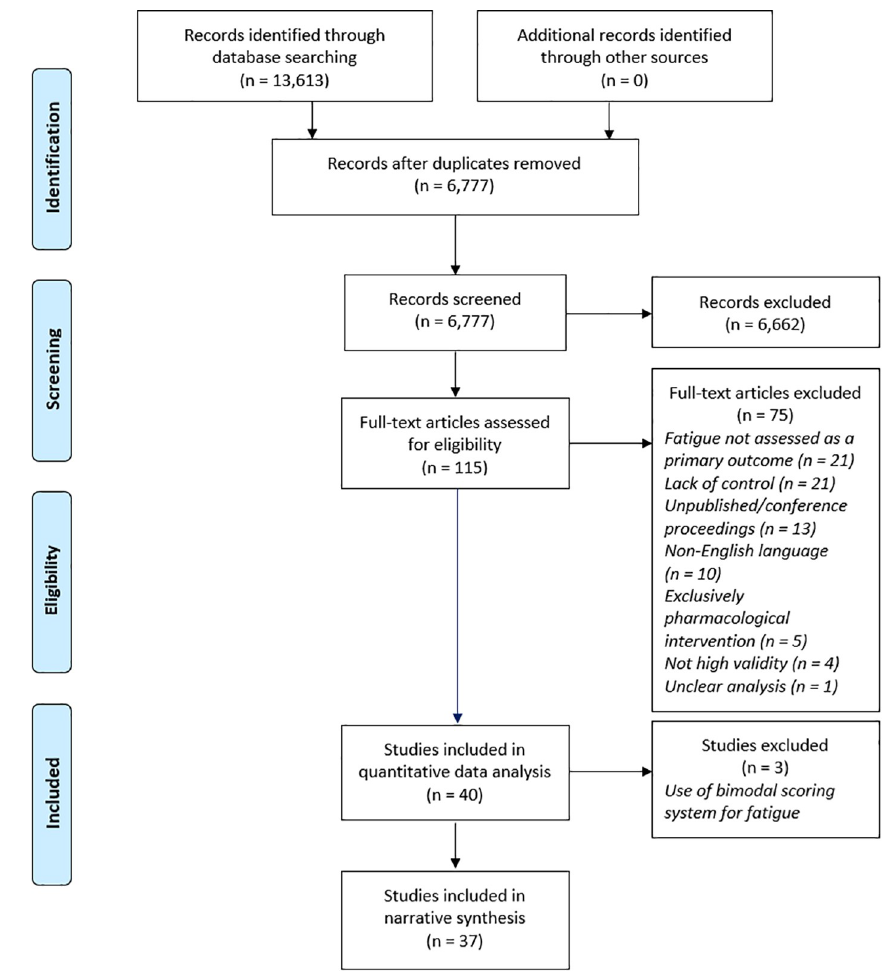
Fig 1. PRISMA flow diagram. Adapted from Moher et al.